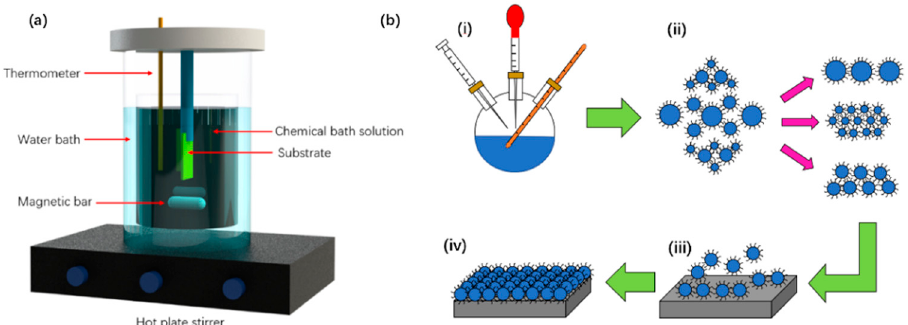
Figure 5. ( a ) Schematic diagram of chemical bath deposition. ( b ) Schematic diagram of the